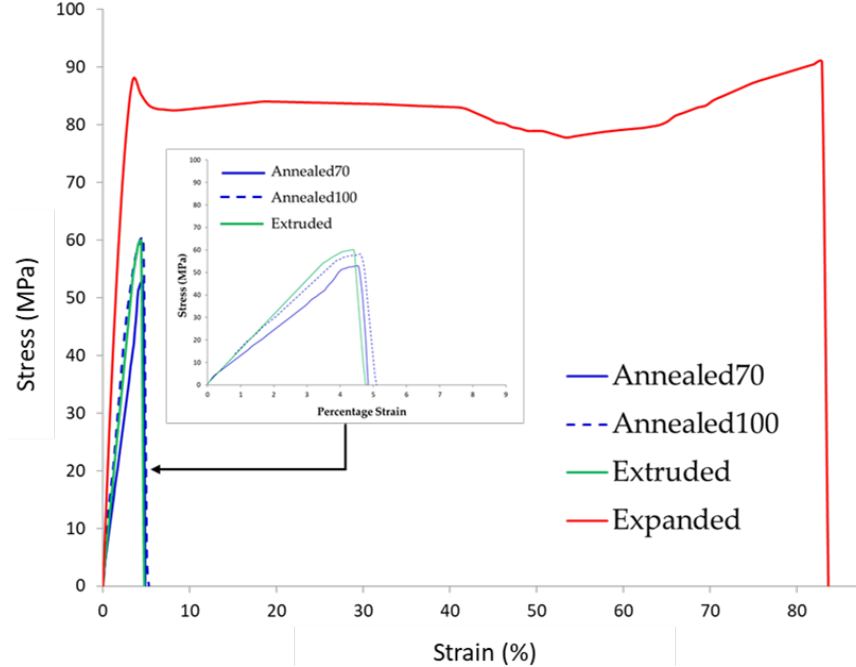
Figure 7. Representative tensile stress/strain curve from Extruded, Annealed70, Annealed100 and Expanded tubing.